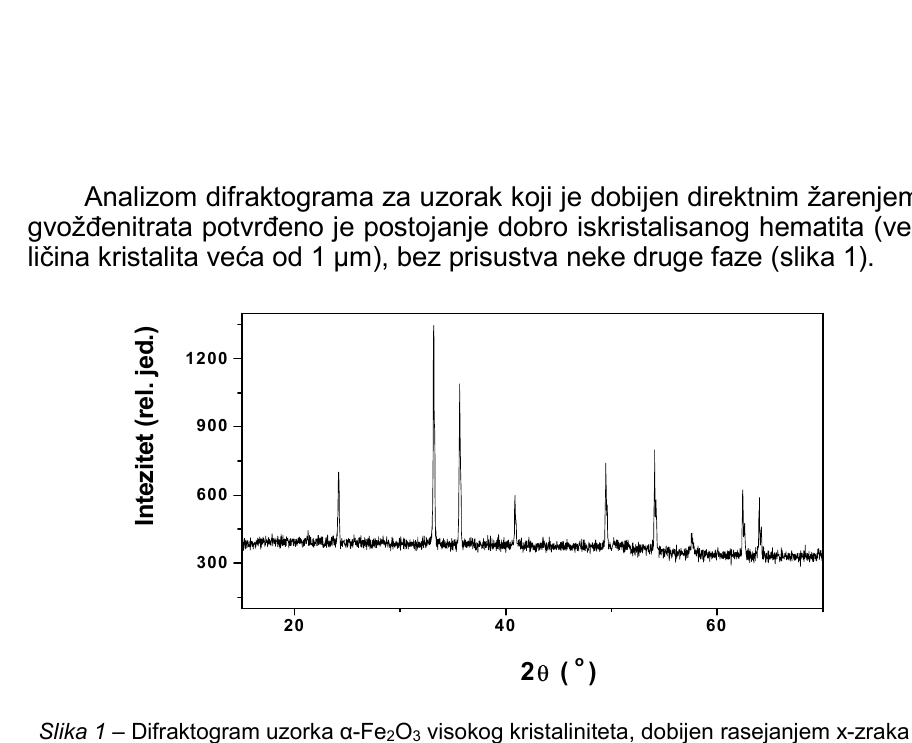
Figure1 – X-ray diffraction pattern of high cristallinity α -Fe 2 O 3 /SiO 2